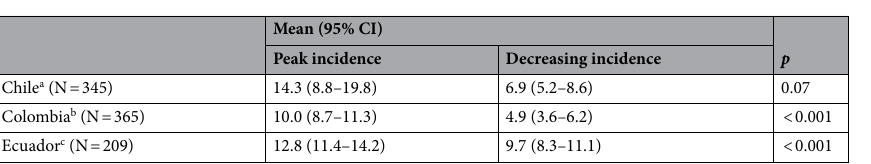
Table 2. Difference in global average at two-time points in the spread of the SARS-COV-2 pandemic in Chile, Colombia and Ecuador. Mann–Whitney U test was performed for the comparison between groups ( p < 0.05). Scores from 0 to 30 in total on the scale. Peak, highest incidence 7 days; Peak, lowest incidence 7 days. a